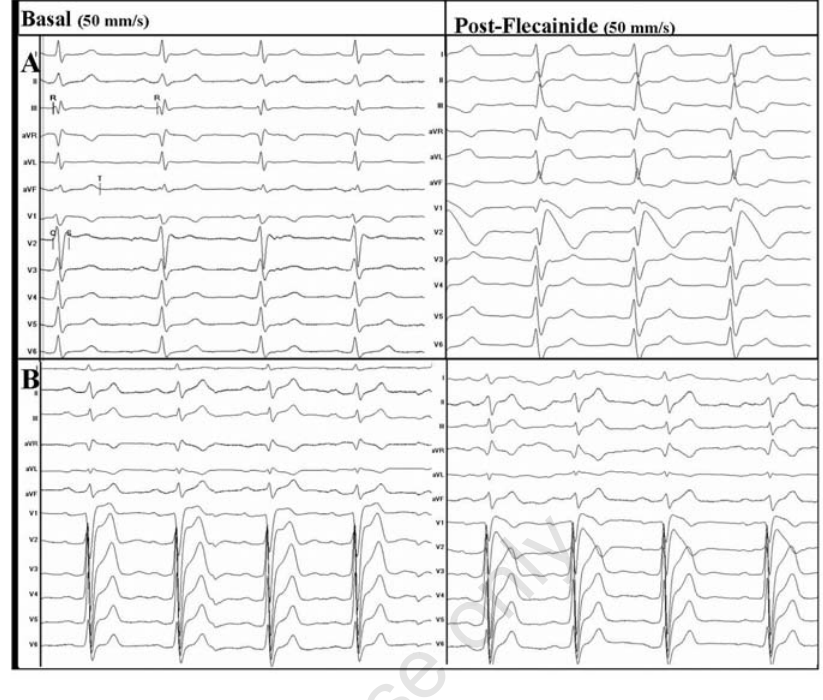
Figure 5. Positive flecainide challenge test for Brugada syndrome in two asymptomatic family members. The baseline electrocardiogram in B also shows a slightly widened